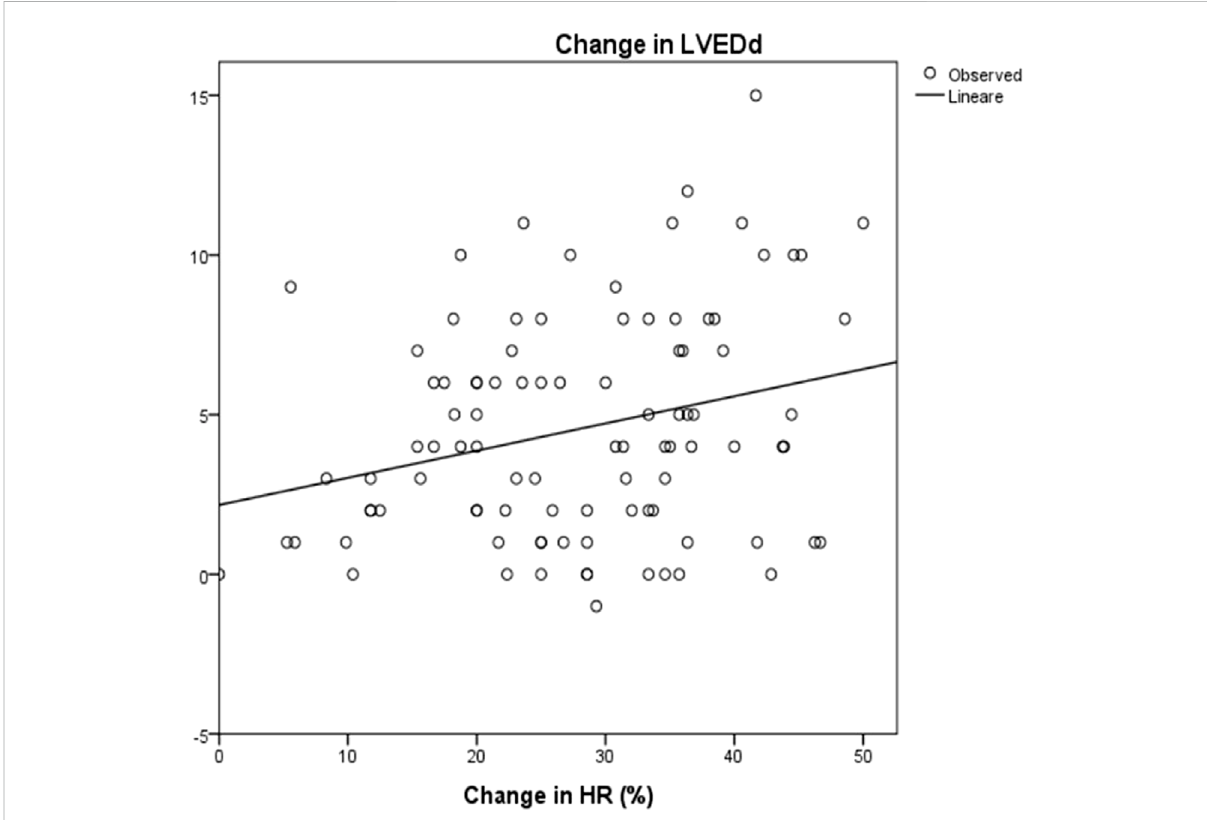
FIGURE 6 CorrelationbetweenchangeinHRandchangeinLVEDd:R20.07; p =0.008HR:Heartrate;LVESd:LeftVentricularEndDiastolicDiameter.The change inenddiastolicdiameter was calculated between baseline andafter 3 yearsoffollowup.ThechangeinHRwas calculatedas thedifferences between baseline and at the maximum dose of